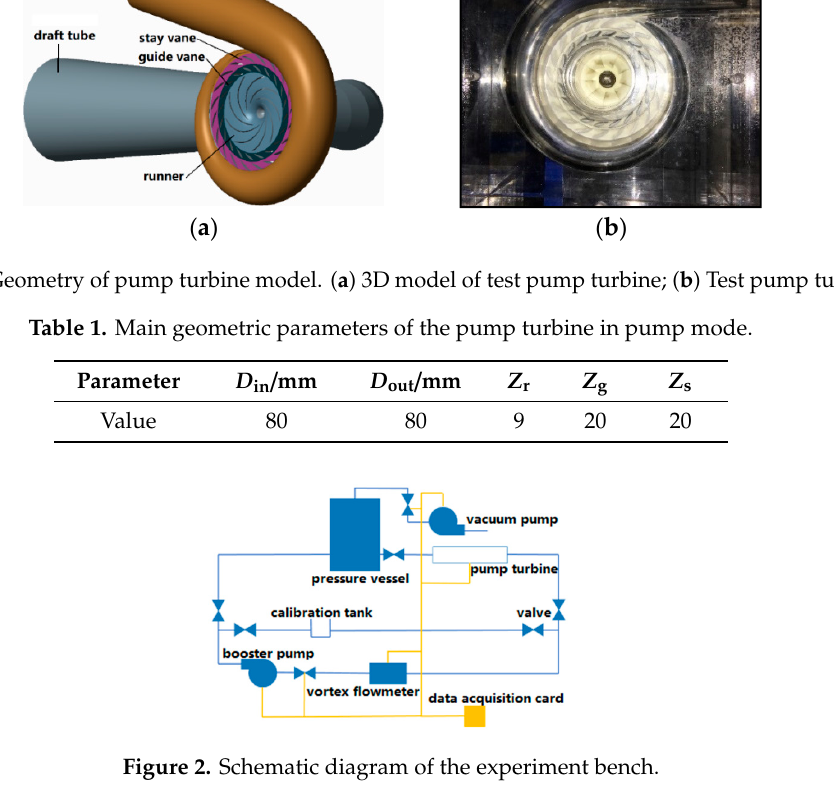
Figure 4. Schematic diagram of monitoring point arrangement. 3.1. Calculation Settings Fluid calculation was carried out by ANSYS CFX 19.0. A smooth and non-slip wall surface, mass flow inlet, and static pressure outlet were adopted in the calculation. The SST k- ω model with better near-wall treatment was chosen for flow separation simulation. The advection scheme and turbulence scheme were both set to High Resolution, and the transient scheme were set to Second Order Backward Euler. The residual RMS (Root-Mean-Square) convergence criterion was set to be 10 -4 . The timestep in the unsteady calculation was 0.0002541 s for the impeller rotating 2°, and the total time was 1.7 s for the impeller to rotate 37 times. As the calculation is not stable enough in the initial stage, the calculation results of the first 10 rotations of the impeller are eliminated to ensure the accuracy of the calculation results. The remaining reliable data covered the frequency domain of 1– 3900 Hz, which satisfied the research need. 3.2. Calculation Feasibility Verification The key characteristic parameters of the pump turbine model when working at the design point under the pump condition are shown in Table 2, where n is the impeller rotating speed, Q N is the design flow rate, H N is the design head, n s is the specific speed, and γ is the guide vane degree. Mass flow rate Q m and pump turbine head H are normalized as q m and h by Q N and H N , respectively, with the corresponding expressions shown in Equations (1) and (2): 𝑞 (cid:2923) = 𝑄 (cid:2923) 𝑄 (cid:2898) ⁄